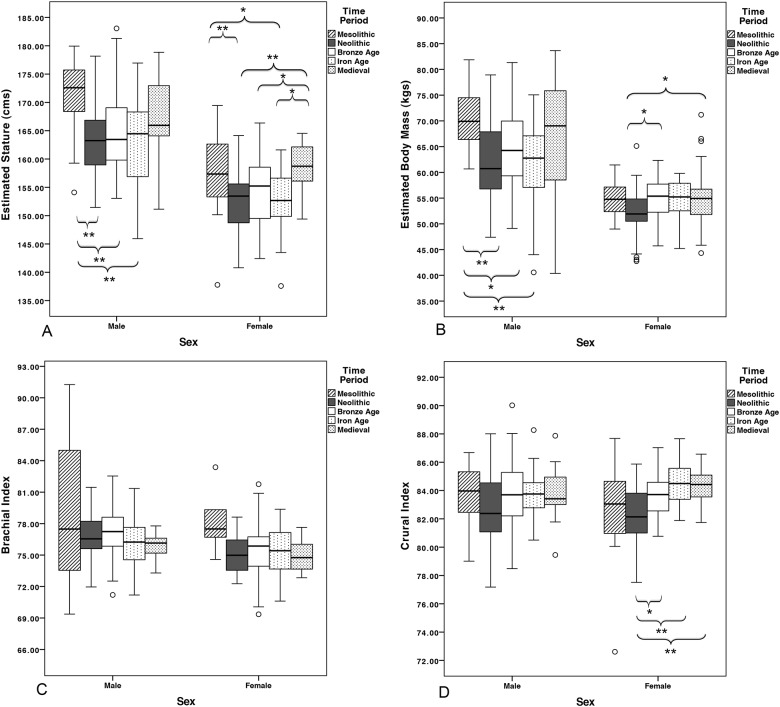
Estimated body size variables by time period and sex.A) Stature, B) Body mass, C) Brachial index, D) Crural index. Brackets indicate significant differences (* = p<0.05; ** = p<0.01).